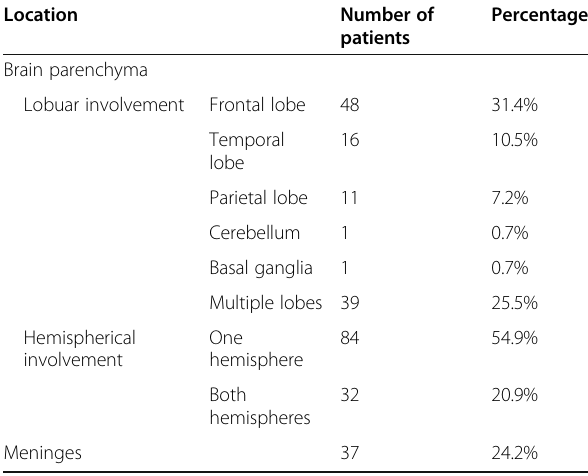
Table 2 Tumor lesions locations in 153 cases of brain tumor- related